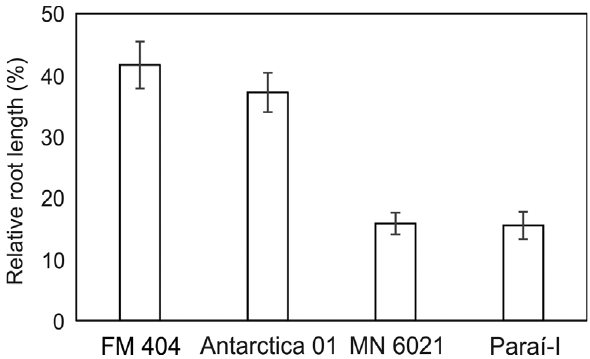
Figure 1 - Relative root length (RRL) of four barley genotypes in relation to Al 3+ tolerance in a short-term soil experiment. The RRL was calculated as the percentage of root length in acidic soil relative to root length in limed soil. The columns represent the mean RRL (cid:5) SE RRL